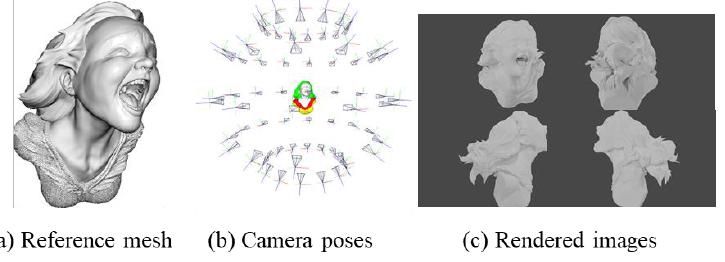
Figure 10. The simulated CG dataset. The three columns are the mesh, cameras, and rendered images from left to right.